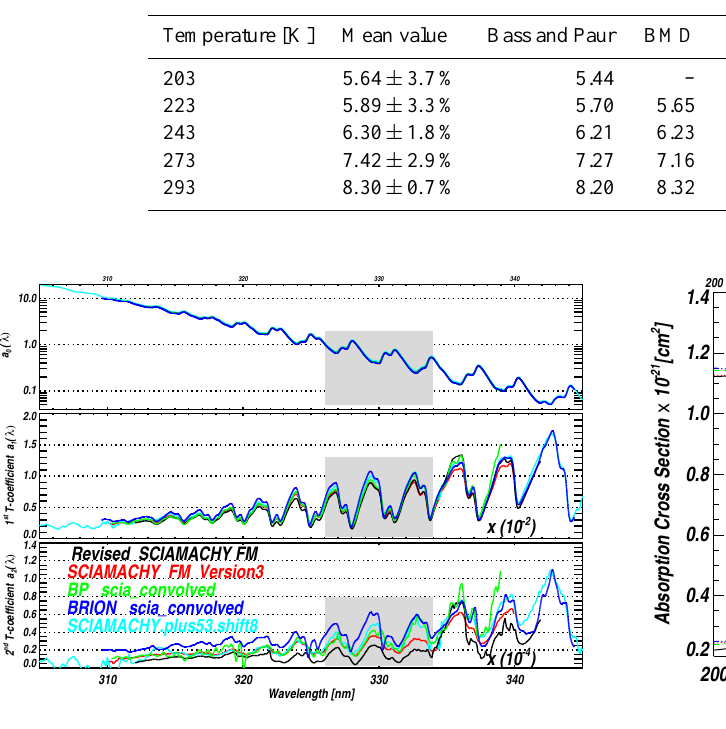
and smaller than Burrows data (Table 3). In this band, inte- grated cross sections show a weak temperature dependence (increase with increasing temperature), which is consistent with Burkholder and Talukdar but not with Burrows data.